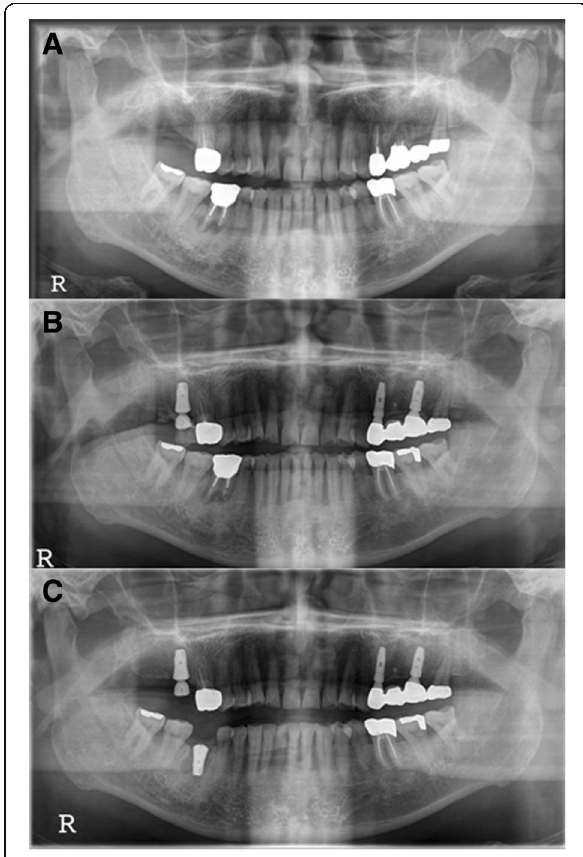
Fig. 1 M3, panoramic radiograph, #46i surgery a initial panoramic radiograph, b pre-operative panoramic radiograph, c postoperative panoramic